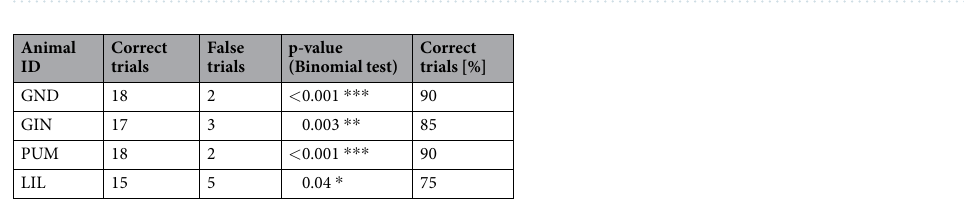
overall time needed for conditioning process.